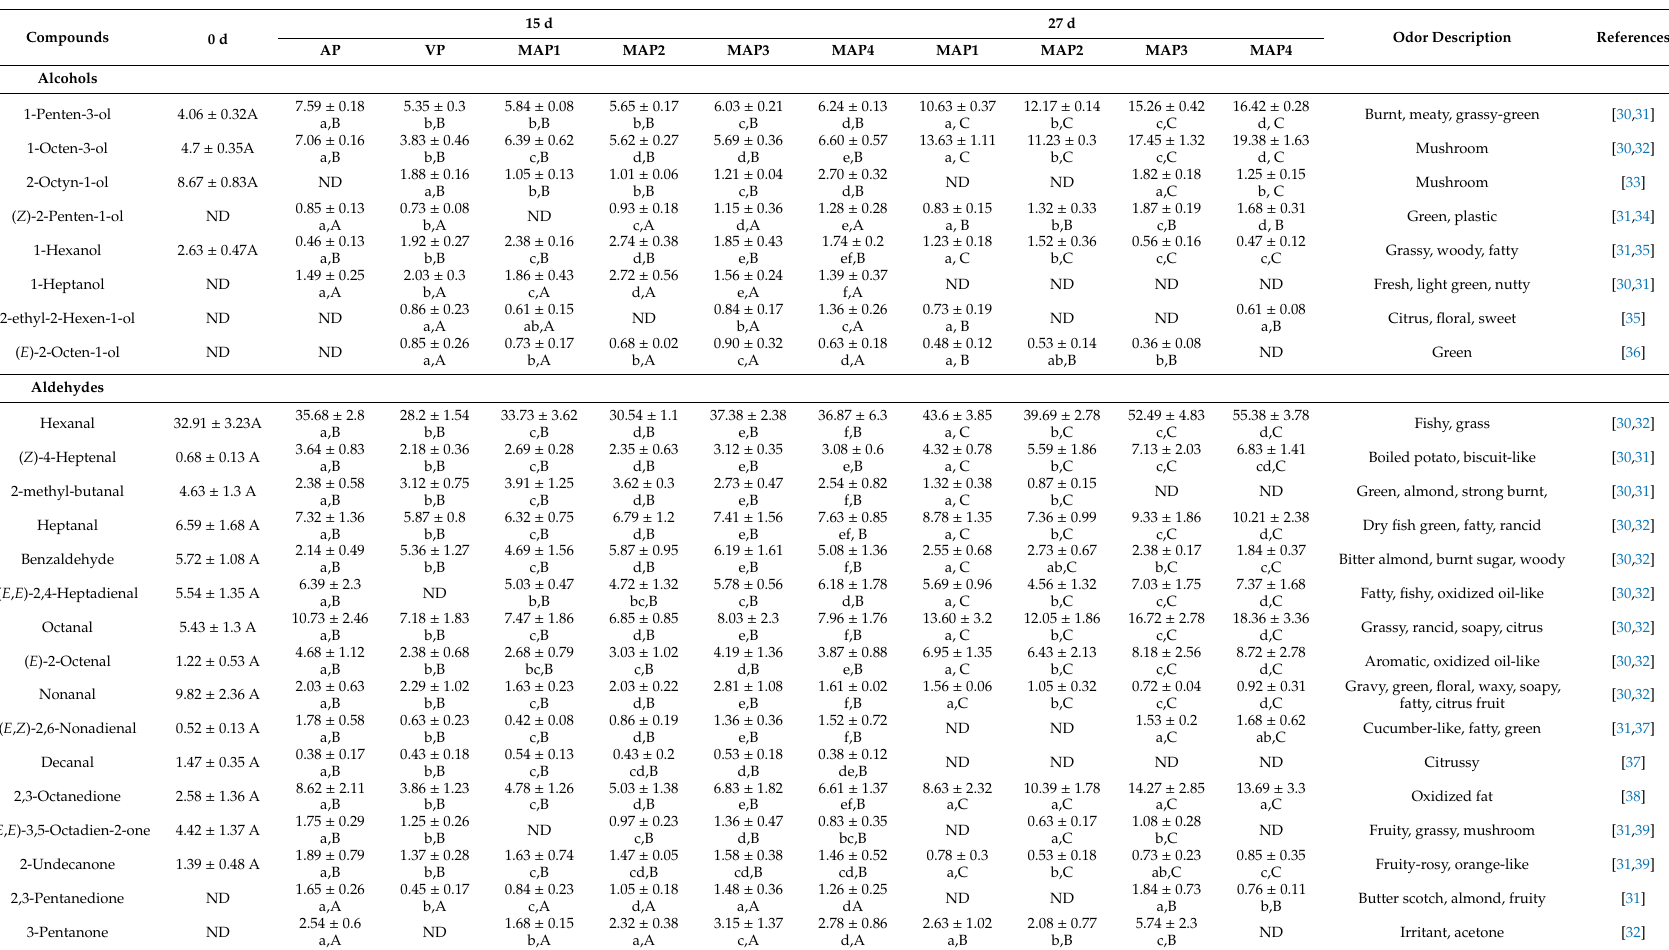
Table 2. Identification and semiquantification of main volatile compounds (peak area × 10 − 6 ) in turbot after 0, 15 and 27 days of the storage.